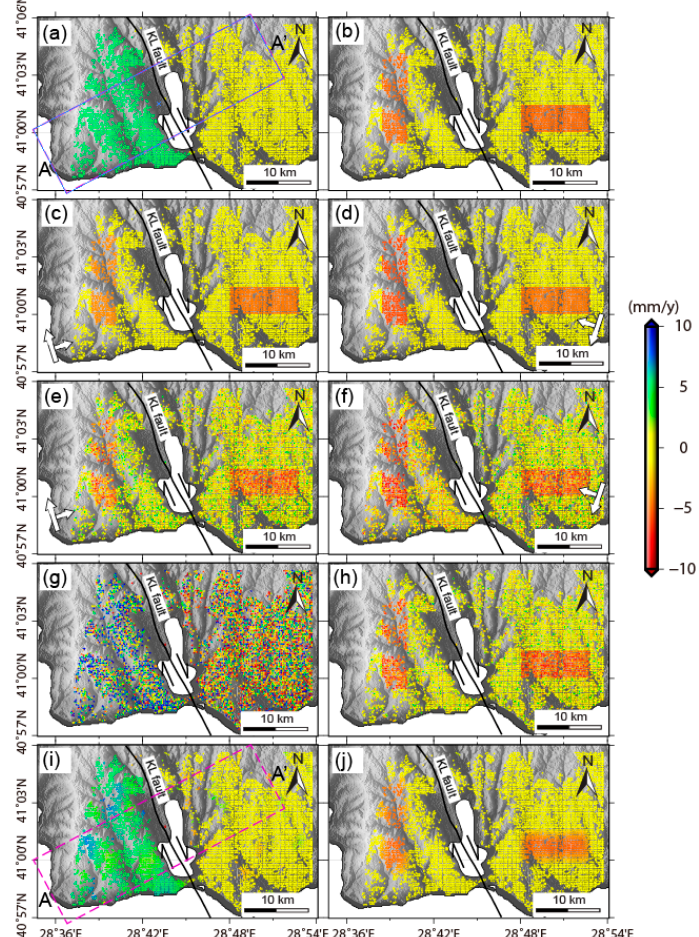
Figure A2. Synthetic data that was used for the test. ( a , b ) Synthetic horizontal ((N30°W) and vertical velocity fields; ( c , d ) Generated LOS velocity fields in the ascending and descending geometric setting; ( e , f ) Inferred from ( c , d ) by adding noise; ( g , h ) Horizontal and vertical velocity that were inverted from noised synthetic LOS velocities ( e , f ); ( i , j ) Low-pass filtered horizontal and vertical velocity field (with a filtering length of 1 km) that were obtained from ( g , h ).